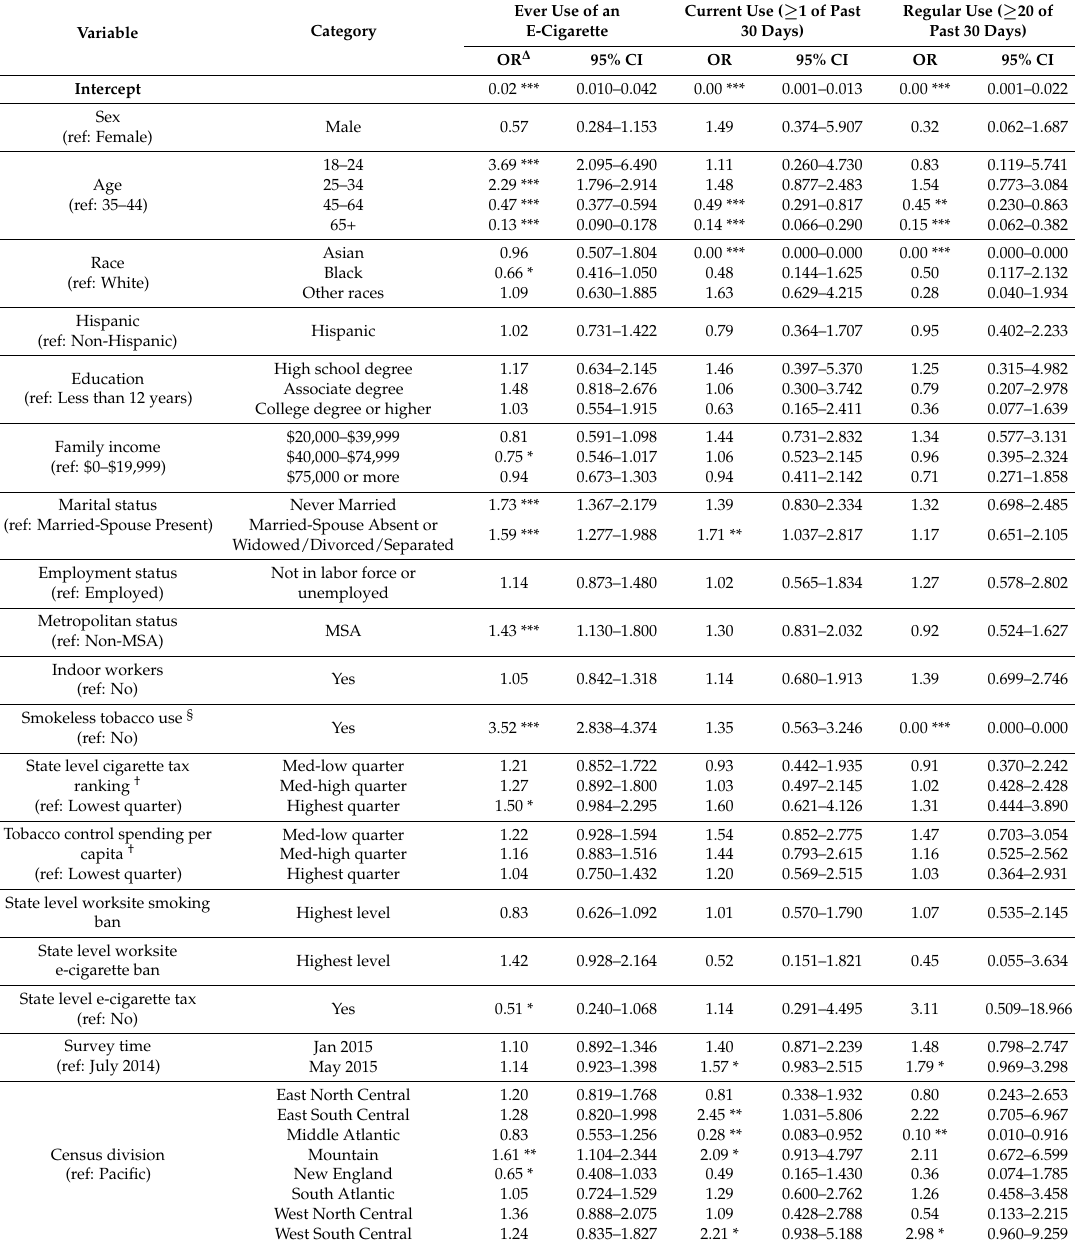
Table 5. Odds ratios for ever, current and regular measures of e-cigarette use of e-cigarette use for former smokers who quit more than three years, CPS-TUS,